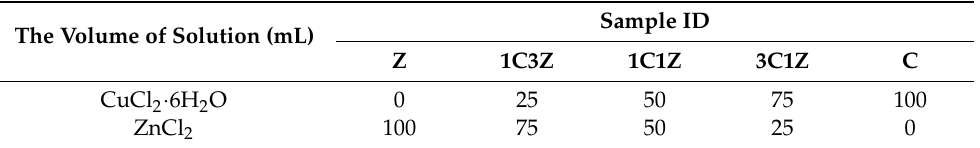
Table 1. The volumetric composition of the CuCl 2 .6H 2 O and ZnCl 2 solutions was used to prepare the